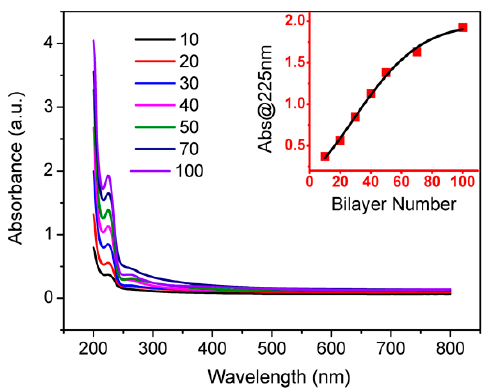
Figure 3. UV-Vis spectra of the (PAH/graphene–PSS) 100 multilayer film growing on a quartz slide. The inset shows the relationship of absorbance at 225 nm versus the number of bilayers assembled.